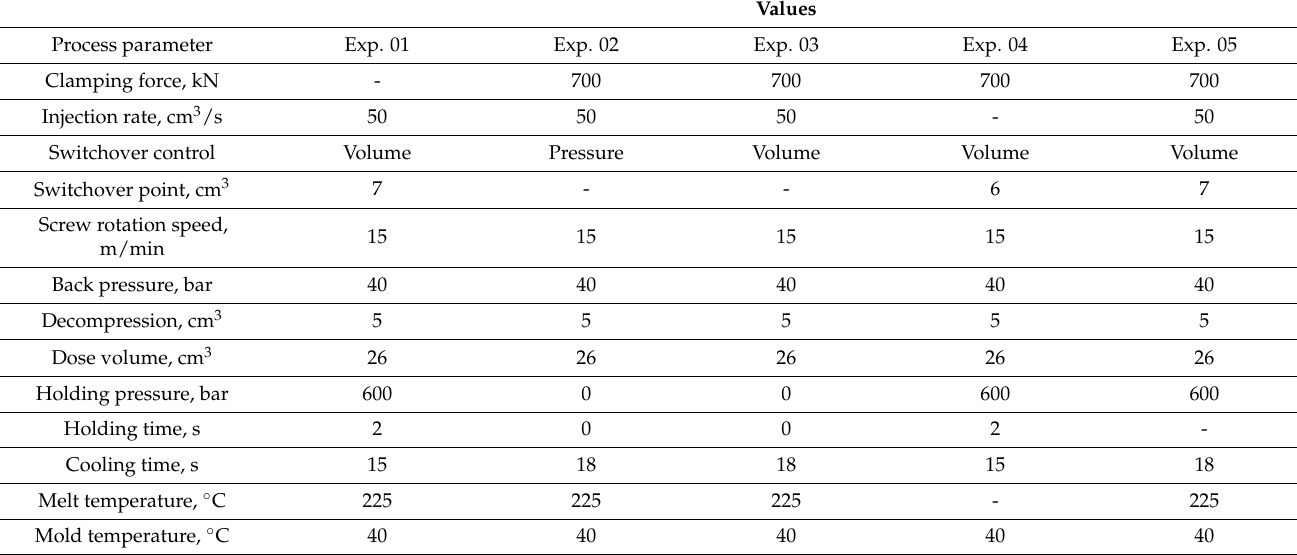
Table 2. Injection molding parameters—fixed parameter set.